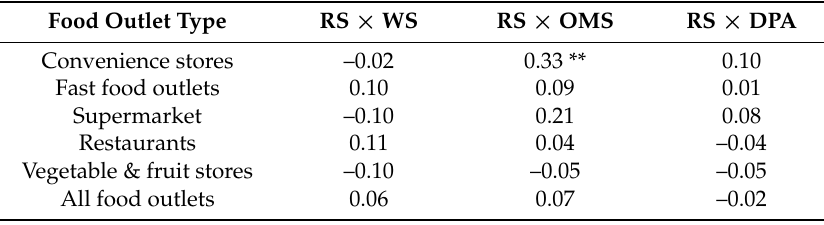
Table 3. Correlation of food outlet counts in residential space (RS), workspace (WS), other major space (OMS), and the non ‐ motorized commuting path area (DPA) ( n = 107). Food Outlet Type RS × WS RS × OMS RS × DPA